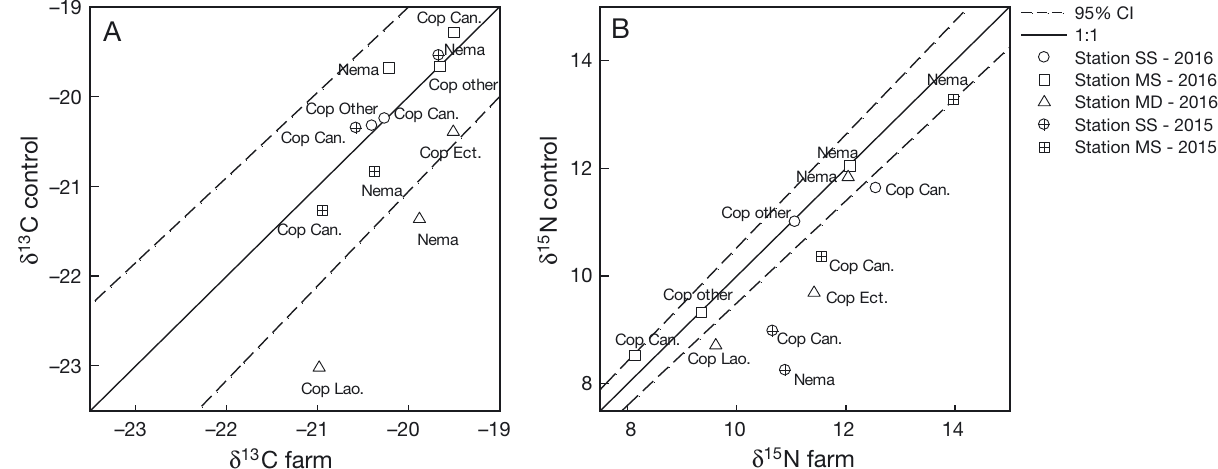
Fig. 3. Comparison of (A) δ 13 C and (B) δ 15 N values for harpacticoid copepod and nematode taxa between ‘farm’ and ‘control’ sites at 3 stations (SS, MS and MD) at scallop farms in Laizhou Bay, China in 2015 and 2016. See Fig. 1 legend for abbreviations of stations. In each panel, the solid line represents a 1:1 correlation between δ 13 C or δ 15 N values at farm and control sites, and the 2 dashed lines show the 95% CI. Values outside the 95% CI are significantly different. Nema: nematodes; Cop Can.: cope- pod family Canuellidae; Cop Ect.: copepod family Ectinosomatidae; Cop Lao.: copepod family Laophontidae; Cop other: rest of the pooled copepods. In 2015, all copepods are pooled but still represented by the dominant family: Canuellidae, representing >70% per